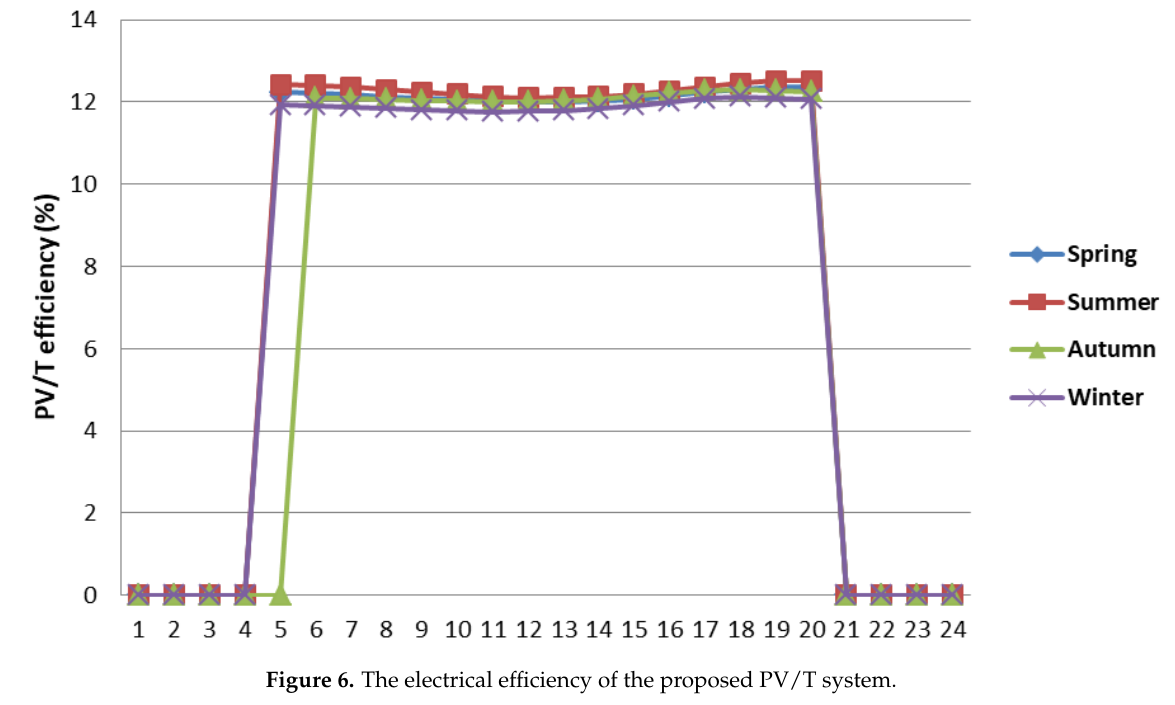
Figure 5. PV/T electricity power generation distribution based on time. The electrical efficiency of the PV/T system at different hours and in different seasons is depicted in Figure 6. A solar panel’s efficiency is dependent on environmental condi- tions, including sunlight, and the panel type. As expected, the electrical efficiency is zero when there is no sunlight, and it slightly changes in the remaining hours due to the sun- light and its angle.